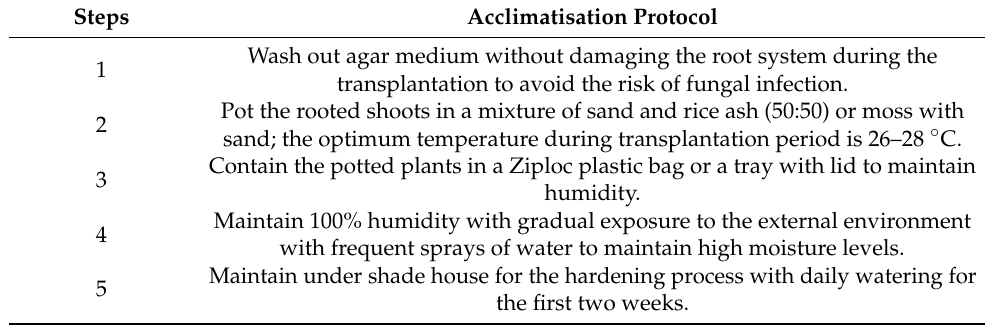
Table 6. Acclimatisation protocol summarised from the work by Lin and Luanratana for Duboisia